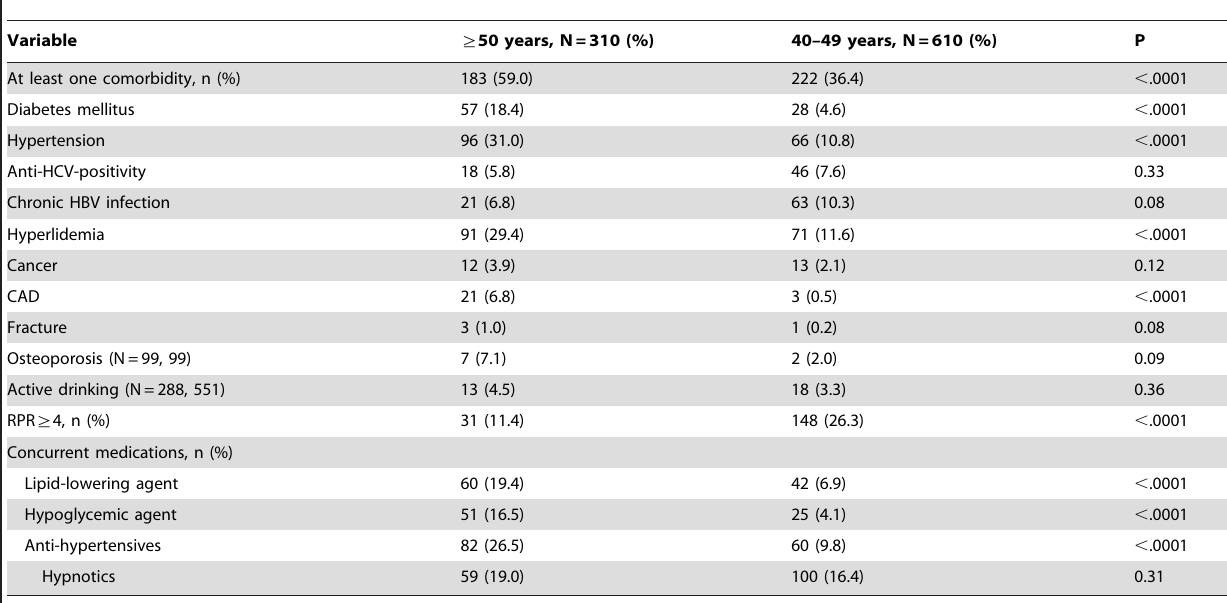
Table 2. Comorbid conditions of the two study populations.